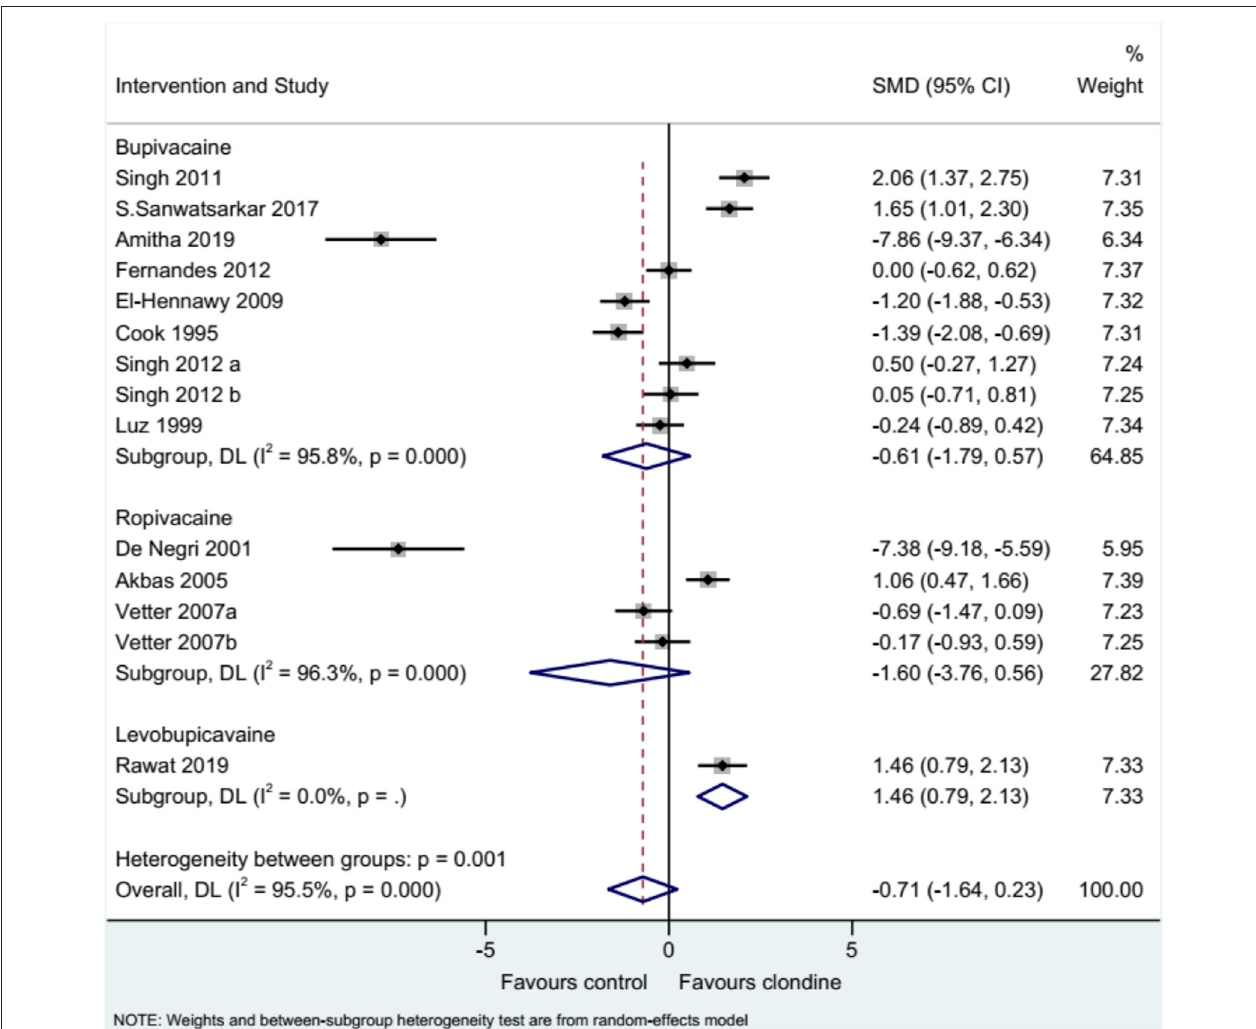
FIGURE 3 | Subgroup analysis of analgesia duration by various local anesthetics.